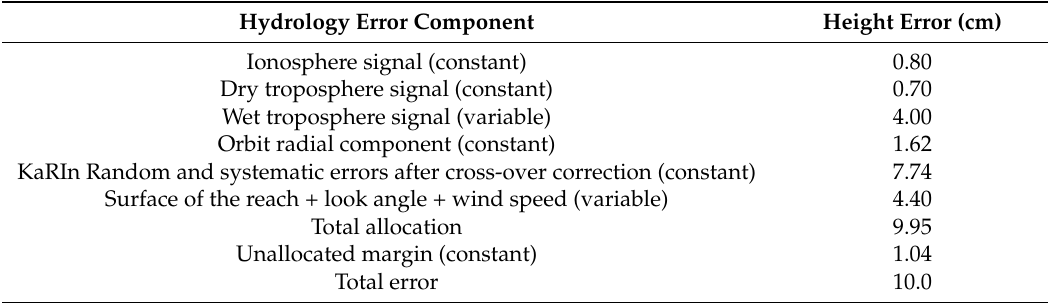
Table 4. SWOT error measurement allocation [35], after averaging over a 1 km 2 area [10]. The left column represents the error component, and the right column represents the values of these